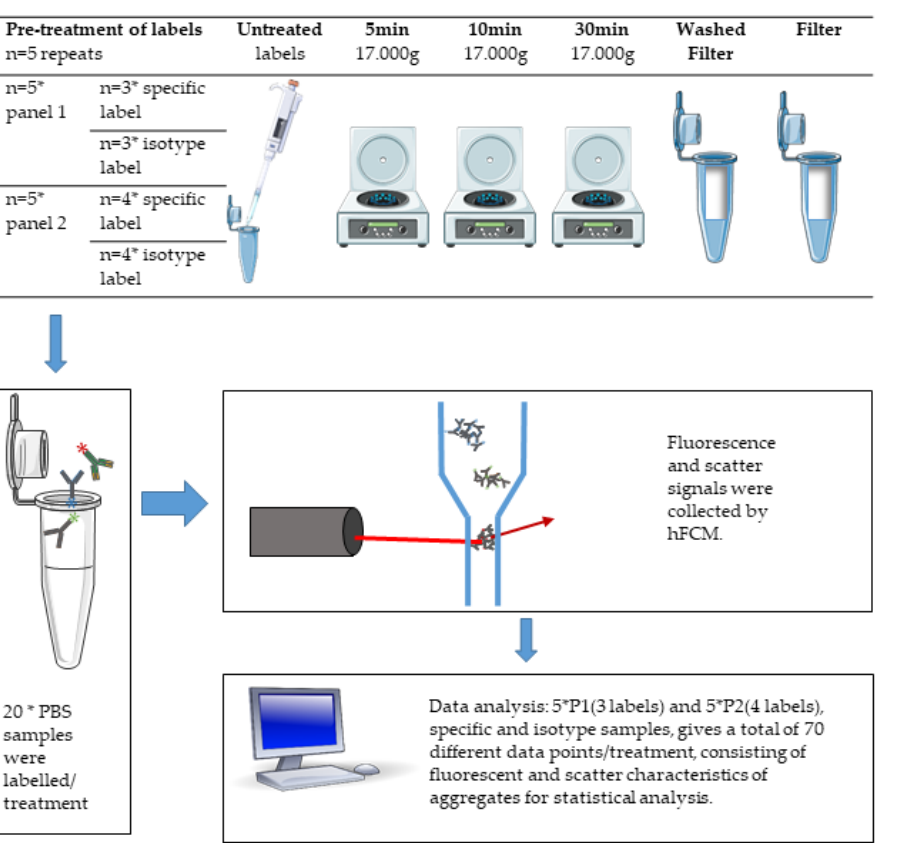
Table 1. Labels used in this study.